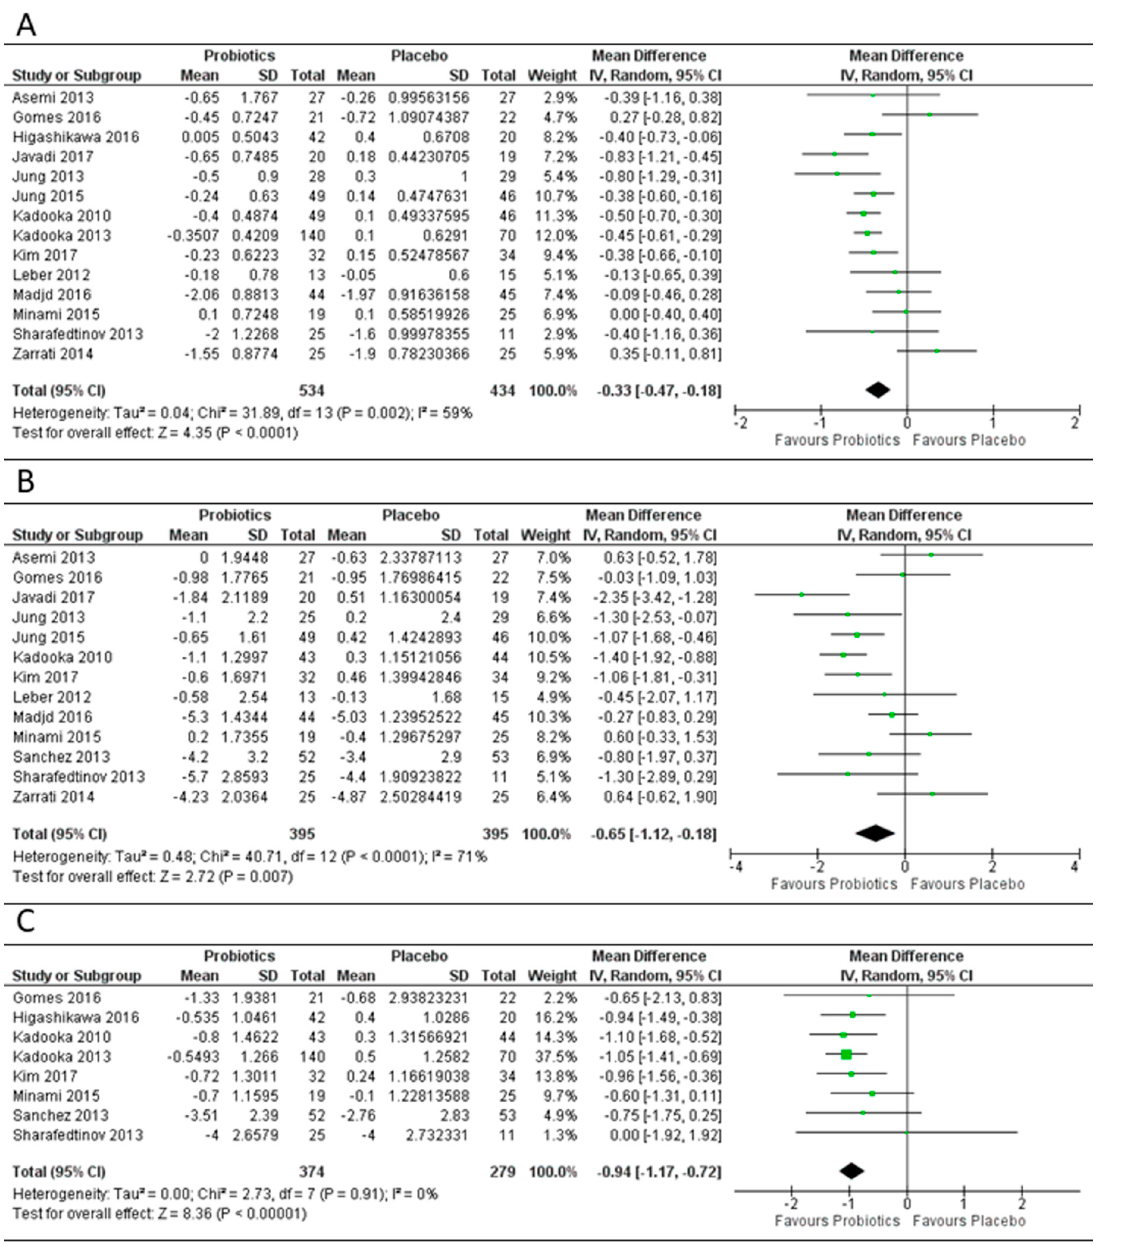
Figure 4. Forest plot of effect of probiotics on: ( A ) BMI; ( B ) body weight; ( C ) fat mass. Data synthesis using the random effects model for the mean differences amongst the included randomized controlled trials comparing probiotics vs. placebo showed significant differences for BMI in 14 study arms ( A ) (overall MD = − 0.33 (95% CI − 0.47, − 0.18), p < 0.001), body weight reduction in 13 study arms ( B ) (MD = − 0.65 kg (95% CI − 1.12, − 0.18), p < 0.01) and fat mass in 8 study arms ( C ) (MD = − 0.94 kg (95% CI − 1.17, − 0.72), p < 0.001). A subgroup analysis stratified by the dose of probiotic used (high dose >30 × 10 9 colony forming units (CFUs), medium dose 1–30 × 10 9 CFUs and low dose <1 × 10 9 CFUs) showed a greater mean decrease in BMI for the study arms with high dose probiotics (mean difference − 0.43 (95% CI − 0.56, − 0.30), p < 0.001) compared to low dose probiotics ( − 0.31 (95% CI − 0.60, − 0.02), p = 0.04) (Figure S2). However, for fat mass, studies using low dose probiotics had a greater mean decrease as compared to studies using high dose probiotics (mean difference − 1.00 kg (95% CI − 1.30, − 0.71) vs. − 0.88 kg (95% CI − 1.23, − 0.54)). Interestingly, when the studies were stratified by dose and duration